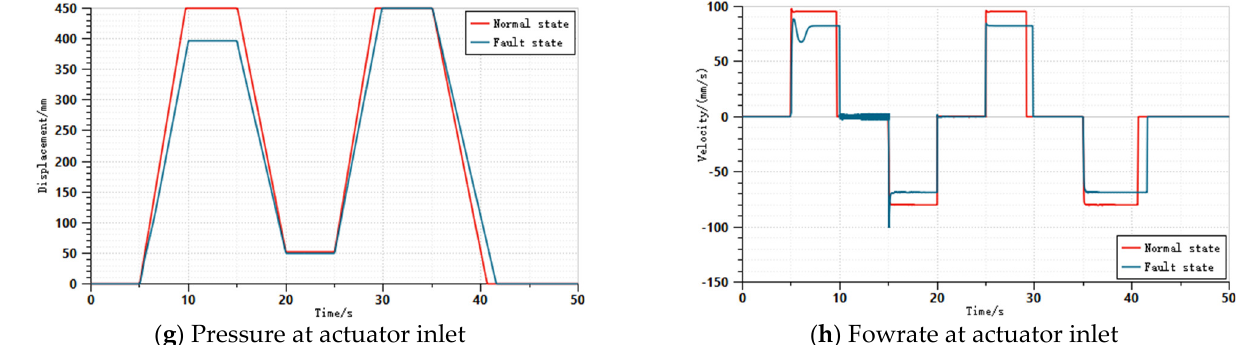
Figure 3. Comparison between the normal state and the air pollution state.